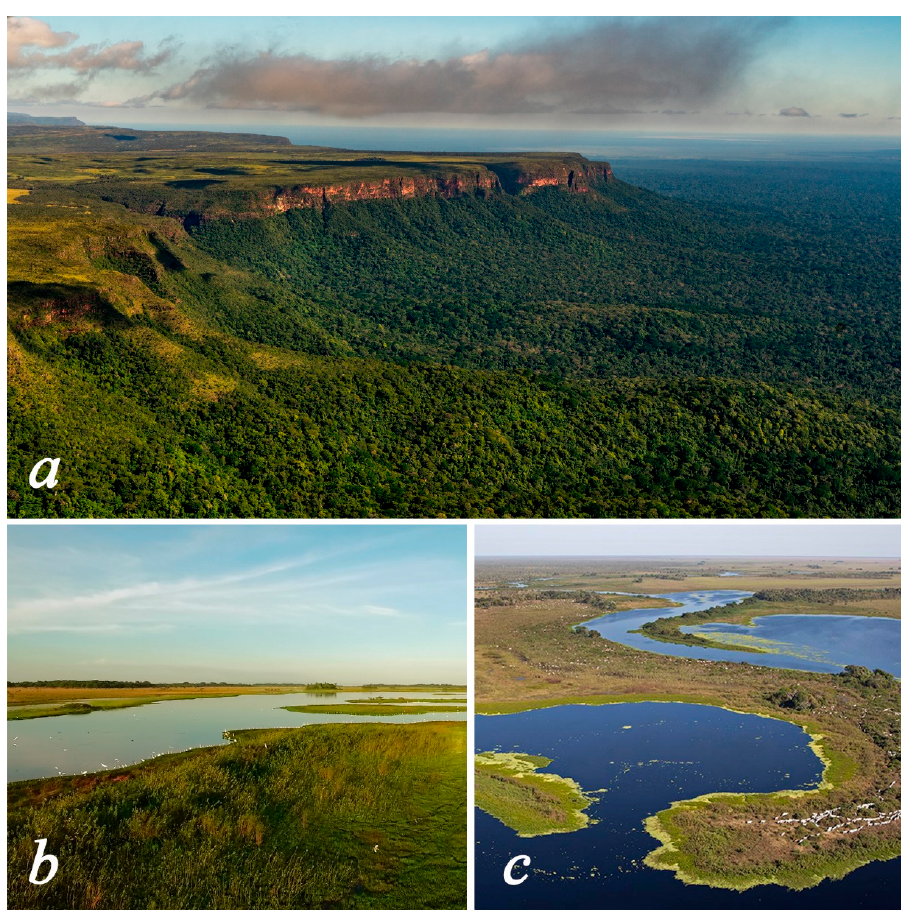
Figure 1. Bolivia’s Key Biodiversity Areas (KBA) affected by wildfires in the last two decades: ( a ) KBA Parque Nacional Noel Kempff Mercado, Serranía de Huanchaca (Claudia Belaunde/FCBC), ( b ) KBA Oeste del río Mamoré, río Ormi (Asociación Armonía), ( c ) KBA Área Natural de Manejo Integrado San Mat í as (Hermes